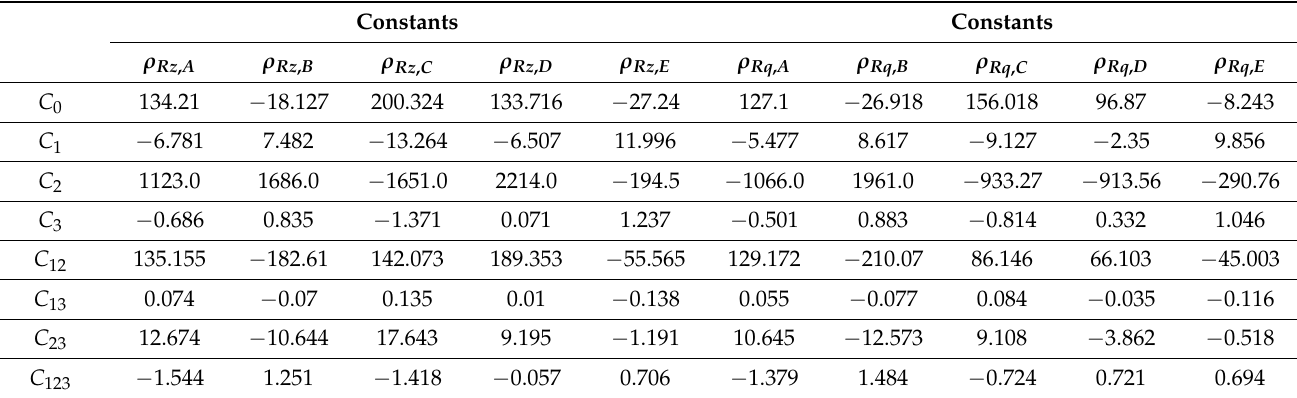
Table 4. The constants for regression improvement equations for R z and R q